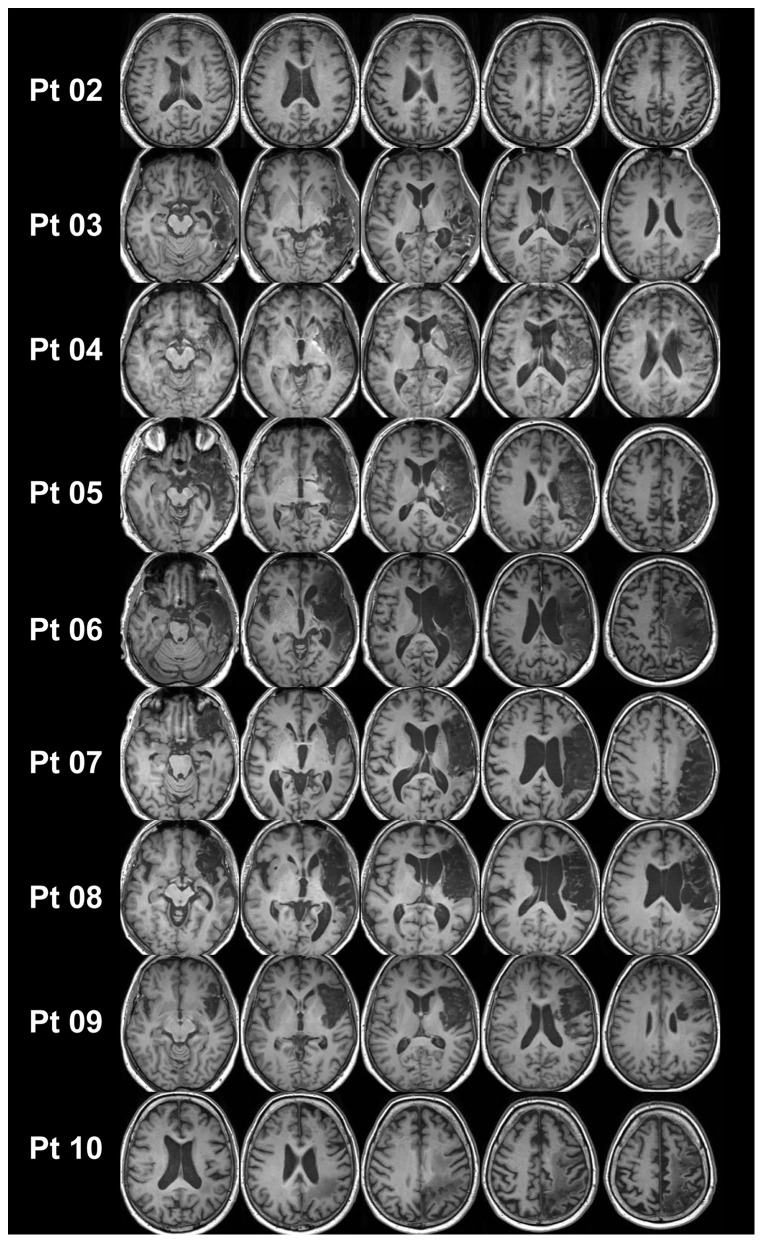
Lesion patterns of individual patients.Patient numbers correspond to patient IDs in Table 1 (patients #2-10). No MRI was available for patient #1. Right side of the brain corresponds to right hemisphere.